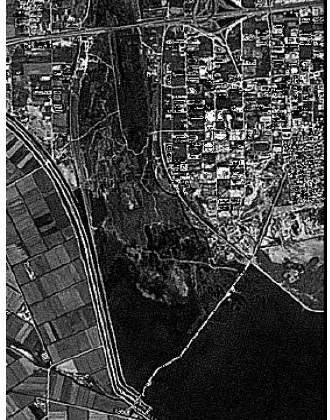
Figure 3c. Gallikos river, 3x3 high pass filtering